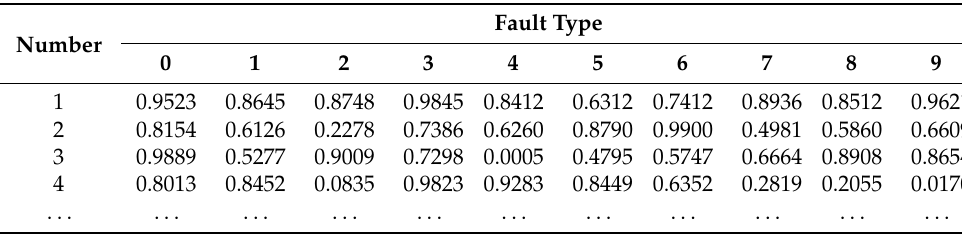
Table 4. CSM similarity between test set and expert fault knowledge base.